Question: Sum up the contents of this chart in one sentence.
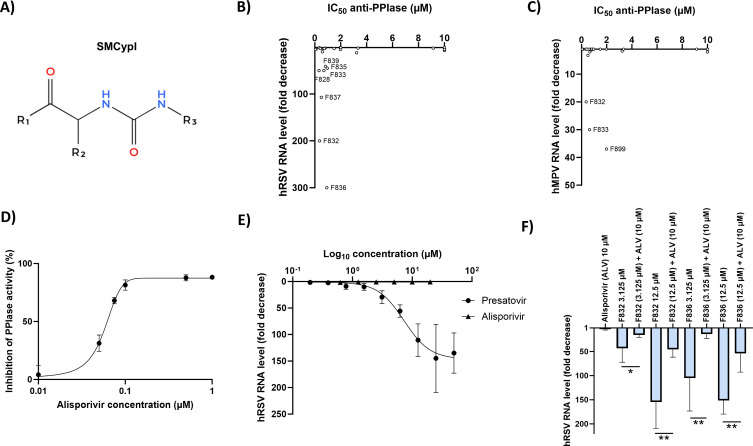
Answer: ( A ) General chemical structure of the SMCypIs with three variable moieties: R1, R2, and R3. ( B ) Relationship between antiviral activity against hRSV of 36 SMCypIs and their PPIase inhibitory activity, as measured by the IC 50 of enzyme activity with purified CypA. ( C ) Relationship between antiviral activity against hMPV of 36 SMCypIs and their PPIase inhibitory activity, as measured by the IC 50 of enzyme activity with purified CypA. ( D ) Dose-response inhibition of CypA PPIase activity by alisporivir. ( E ) Antiviral activity of presatovir and alisporivir against hRSV. ( F ) Antiviral activity of compounds F832 and F836 against hRSV at 3.125 and 12.5 µM, alone and in competition with alisporivir at 10 µM in HEp-2 cells. The data are presented as the mean ± standard deviation (SD) from at least two independent experiments. A two-tailed Student’s t -test was applied. * P -value < 0.05; ** P -value < 0.01.